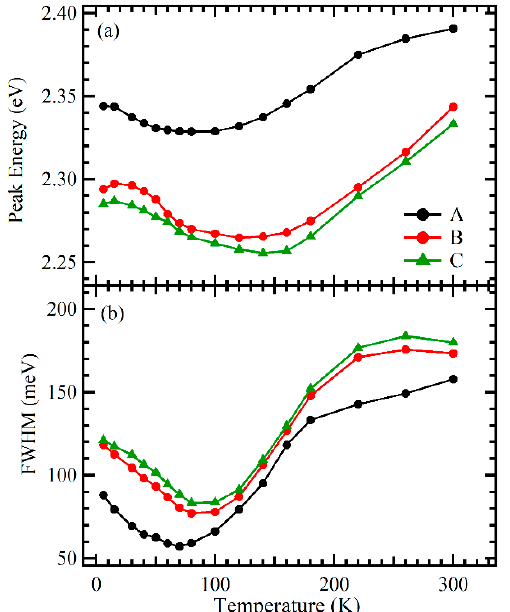
Figure 4. Temperature dependence of EL peak energy ( a ) and line width ( b ) of samples A, B, and C at 2 mA.